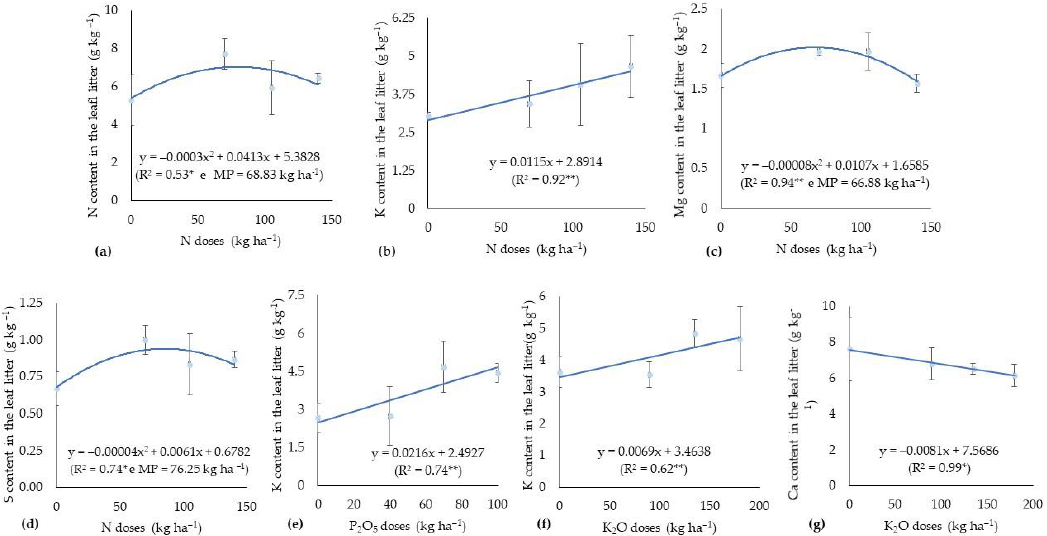
Figure 3. ( a ) Nitrogen, ( b ) potassium, ( c ) magnesium and ( d ) sulfur content in eucalyptus leaf litter as a function of residual N dose. ( e ) Potassium content in eucalyptus leaf litter as a function of residual P 2 O 5 dose. ( f ) Potassium and ( g ) calcium content in eucalyptus leaf litter as a function of residual K 2 O dose. Each point located on each graph is the mean of five replications. * and ** = significant at 5 and 1% level by F test, respectively. Table 4. Micronutrient contents in eucalyptus leaf litter as a function of residual dose of N, P 2 O 5 and K 2 O.